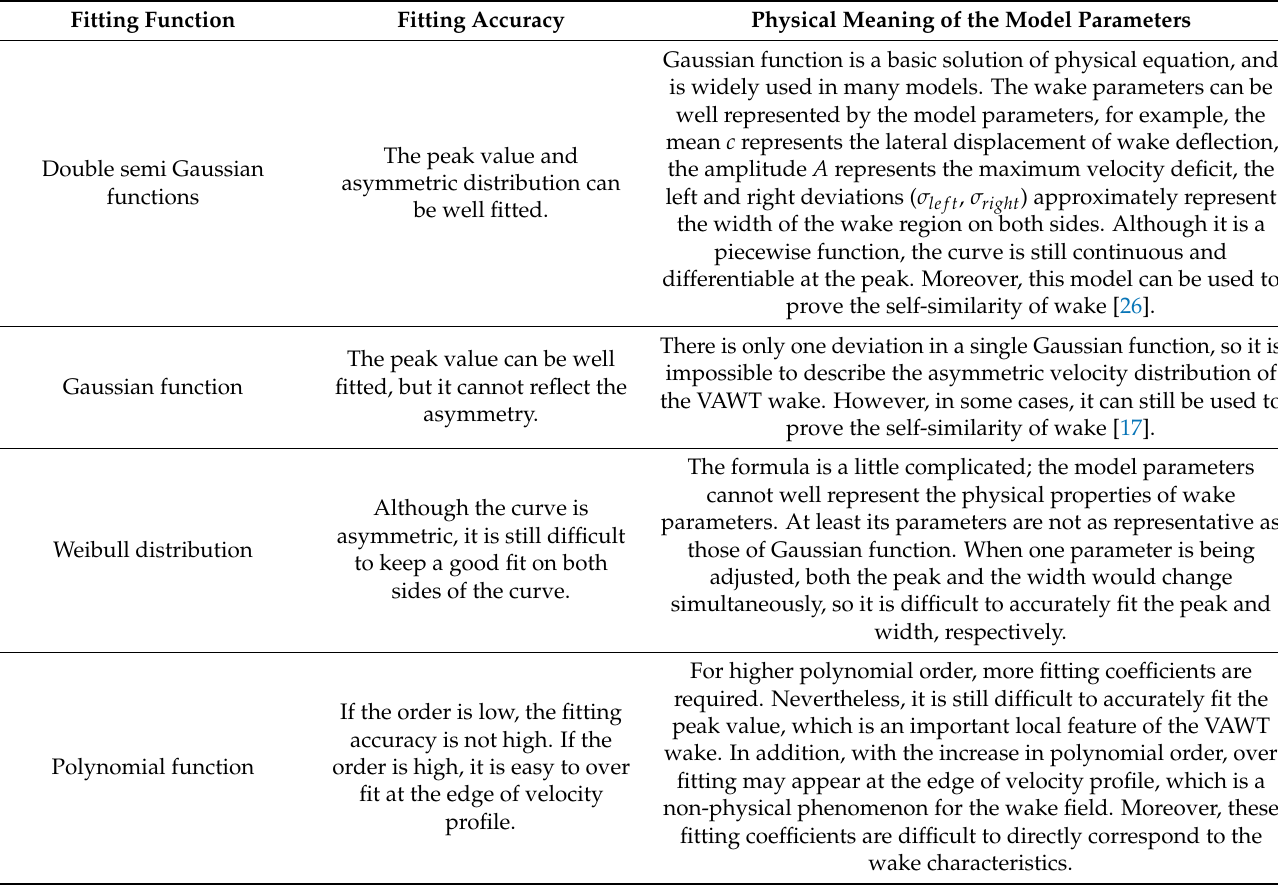
Table 3. The comparison and summary of these fitting